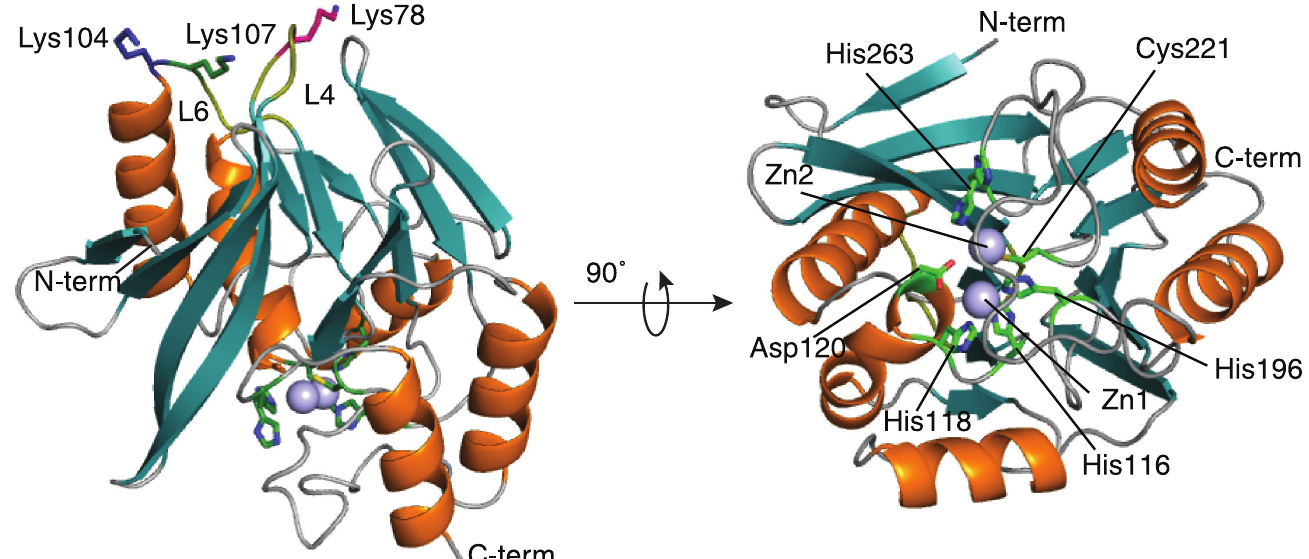
Fig 2. X-ray crystal structure of 5/B/6 MBL shows the typical MBL fold. Secondary structural elements are colored deep teal for beta sheets and orange for alpha helices; whereas, turns/coils are colored grey and the Zn 2+ atoms are represented by light blue spheres. The left panel shows the overall enzyme structure with lysine residues at the allosteric site in Loop 4 (L4) and Loop 6 (L6). The right structure shows the active site residues that are responsible for coordinating the two Zn 2+